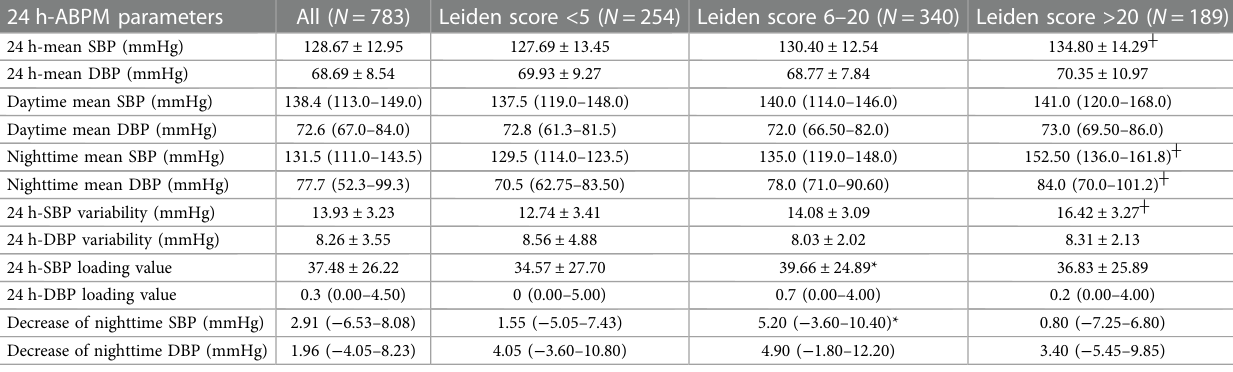
TABLE 2 24 h-ABPM parameters across the different groups of Leiden score.